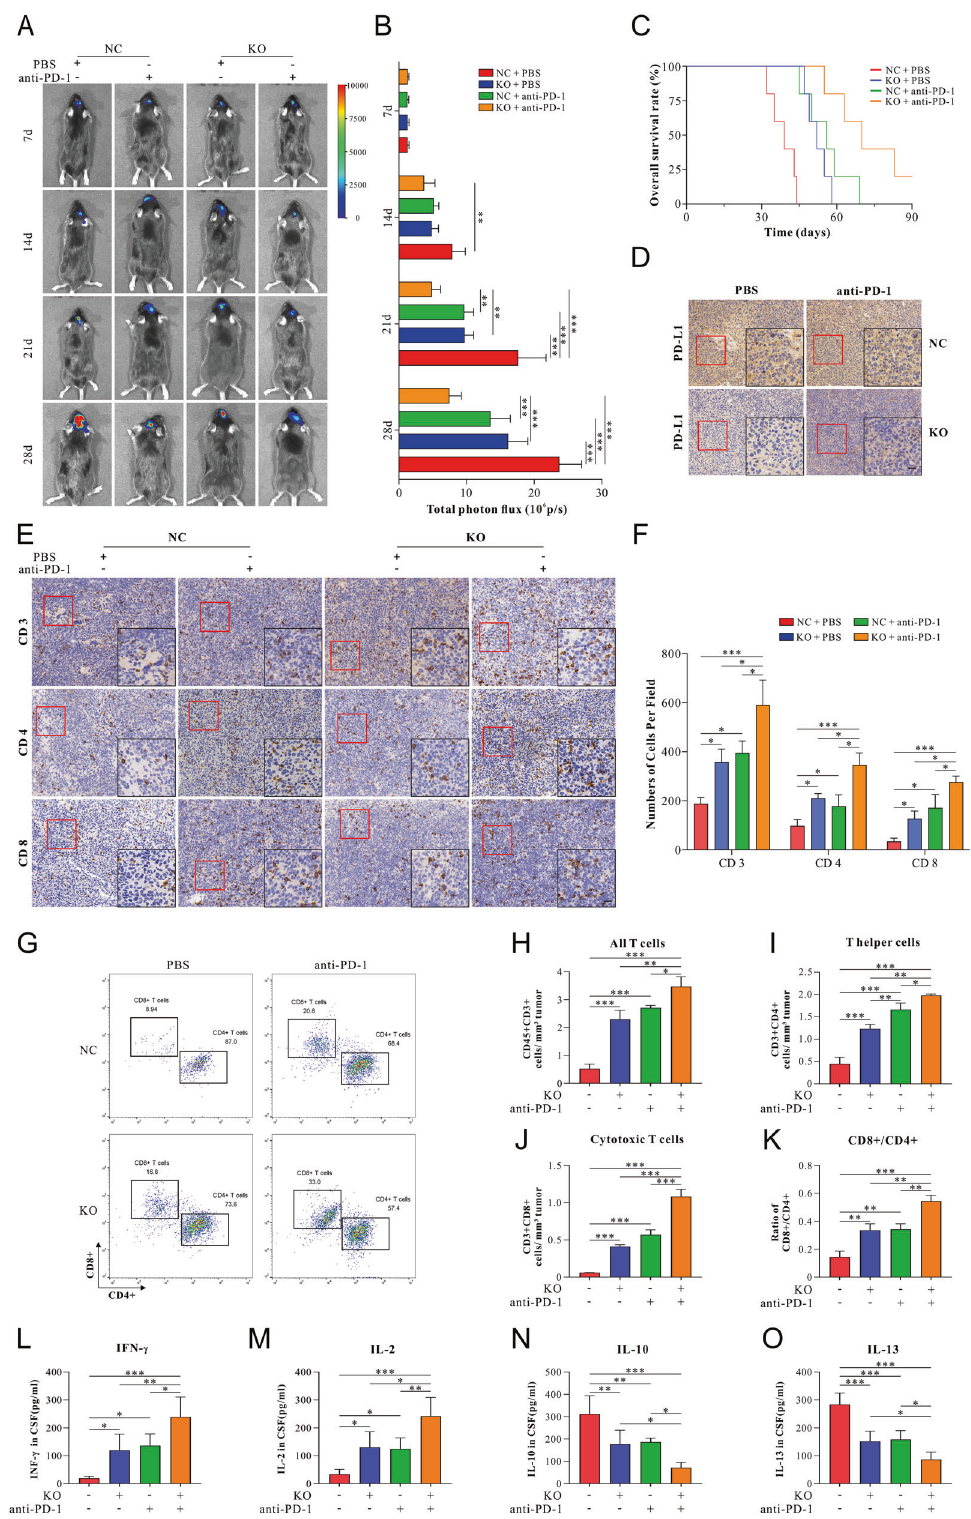
U251 cells for m6A pro fi ling and transcriptome pro fi ling using m6A-methylated RNA immunoprecipitation sequencing and RNA sequencing (RNA-Seq). Motif searching identi fi ed that the consensus “ GGAC ” motif was highly enriched within the m6A sites in ALKBH5-KO U251 cells (Fig.